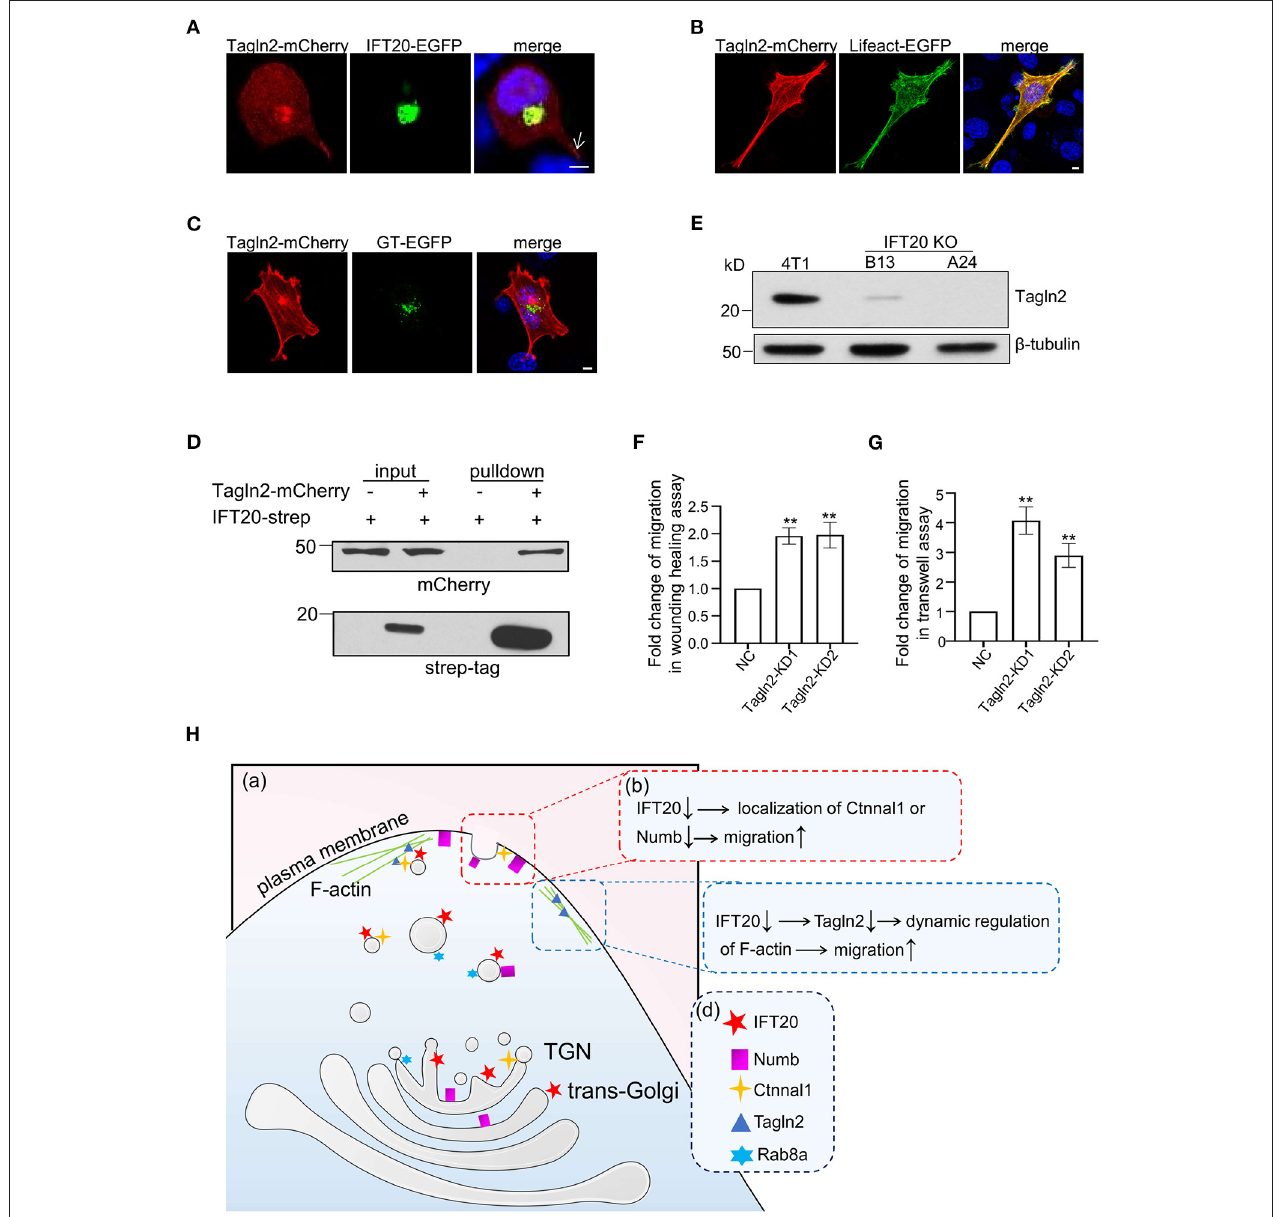
FIGURE 8 | Interactions of IFT20 with the F-actin associated protein Tagln2 regulates the migration of breast cancer cells. (A) Representative fluorescent images of 4T1 cells co-expressing IFT20-EGFP and Tagln2-mCherry showed that IFT20 co-localizes with Tagln2. Arrow indicates the signal of Tagln2-mCherry at the cell projection. (B) Representative fluorescent images of 4T1 cells expressing Tagln2-mCherry and Lifeact-EGFP showing the F-actin localization of Tagln2. (C) Representative fluorescent images of 4T1 cells co-expressing GT-EGFP and Tagln2-mCherry showing the adjacent localization of Tagln2-mCherry to GT-EGFP. (D) Strep-pulldown assay of IFT20-Strep and Tagln2-mCherry. HEK293T cells were transfected with plasmids that express Tagln2-mCherry combined with or without IFT20-Strep expression plasmid. After 24h, the cells were lysed and centrifuged. The supernatants (input) were incubated with Strep-Tactin beads, and the proteins bound to the beads (pulldown) were analyzed by Western blot using anti-Strep tag or anti-mCherry antibodies. (E) Western blots of cell lysates from 4T1 and IFT20-knockout mutants (B13 and A24) probed with Tagln2 antibodies showing the downregulation of Tagln2 in IFT20-KO cells. β -tubulin was used as the loading control. (F,G) Quantification of the migration efficiency in the wound healing (F) and transwell (G) assays showed that the downregulation of Tagln2 significantly enhanced cell migration. (H) A working model of IFT20-associated vesicles transporting Numb and Ctnnal1 to the plasma membrane in breast cancer cells. (a) Trans-Golgi/TGN localized IFT20 is involved in the vesicle transport of Numb and Ctnnal1 from the Golgi to the plasma membrane, which is overlapped with the Rab8a-positive trafficking pathway. (b) The amount of Numb and Ctnnal1 decreased at the plasma membrane because of the loss of IFT20, which enhances the migration of 4T1 cells. (c) IFT20 interacts with F-actin-associated protein Tagln2; loss of IFT20 causes the downregulation of Tagln2, which enhances the migration of 4T1 cells. (d) A key showing the shapes used in the illustration and their corresponding cellular components. All quantitative graphs were constructed with data from three independent experiments and date are expressed as the mean ± S.D.; n.s. (not significant) p > 0.05; * p ≤ 0.05; ** p ≤ 0.01. All fluorescent experiments were performed three times. The nucleus was stained by DAPI (blue); scale bar, 5 µ m.